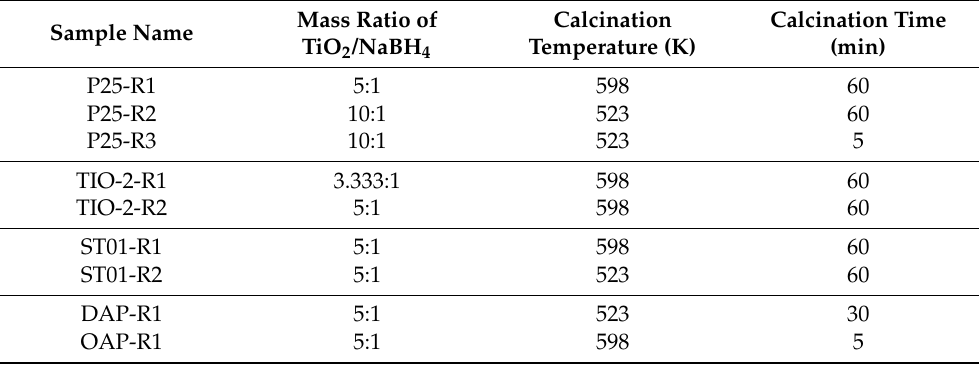
Table 5. The preparation conditions of black titania